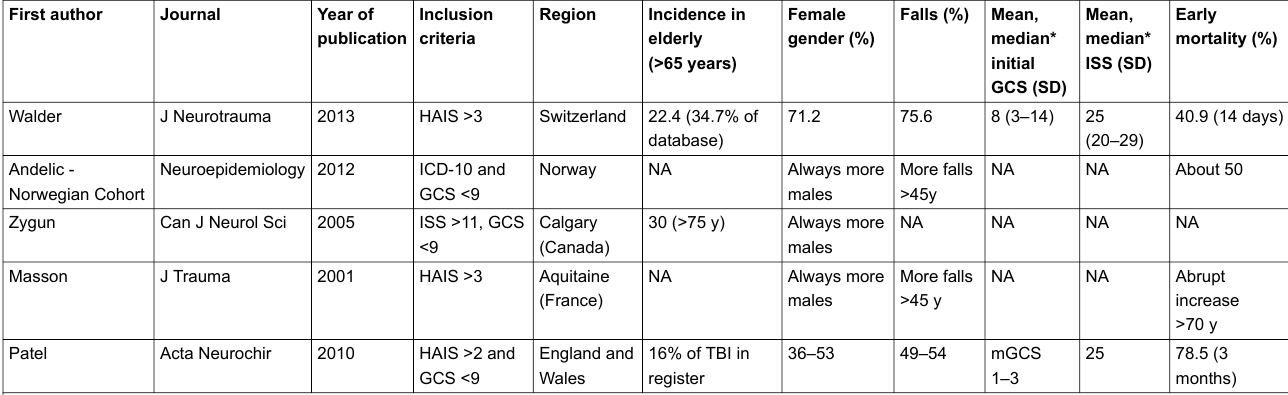
Table 5: Large, multicentre cohort studies in high-income countries reporting on short-term mortality in elderly adults with traumatic brain injury. First